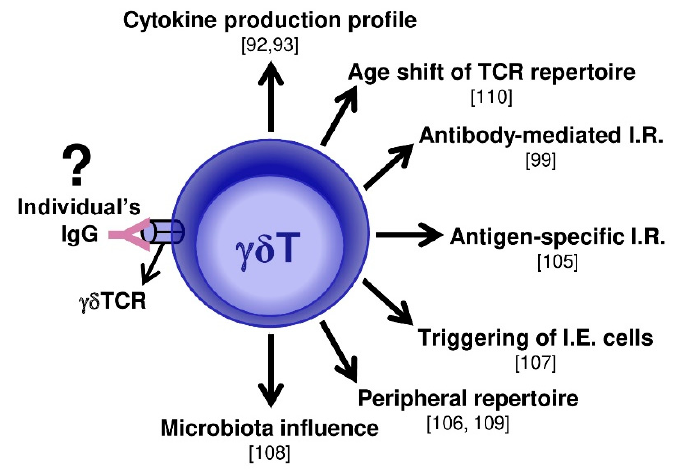
Figure 2. Possible γδ T cell-mediated mechanisms that can be influenced by IgG. The main immunologic mechanisms mediated by γδ T cells described in the literature, where IgG can be an influence by specifically interacting with γδ TCRs, are illustrated with their respective references in brackets. ? = proposed non-evidenced ligand; I.R. = immune response; I.E. = intraepithelial.